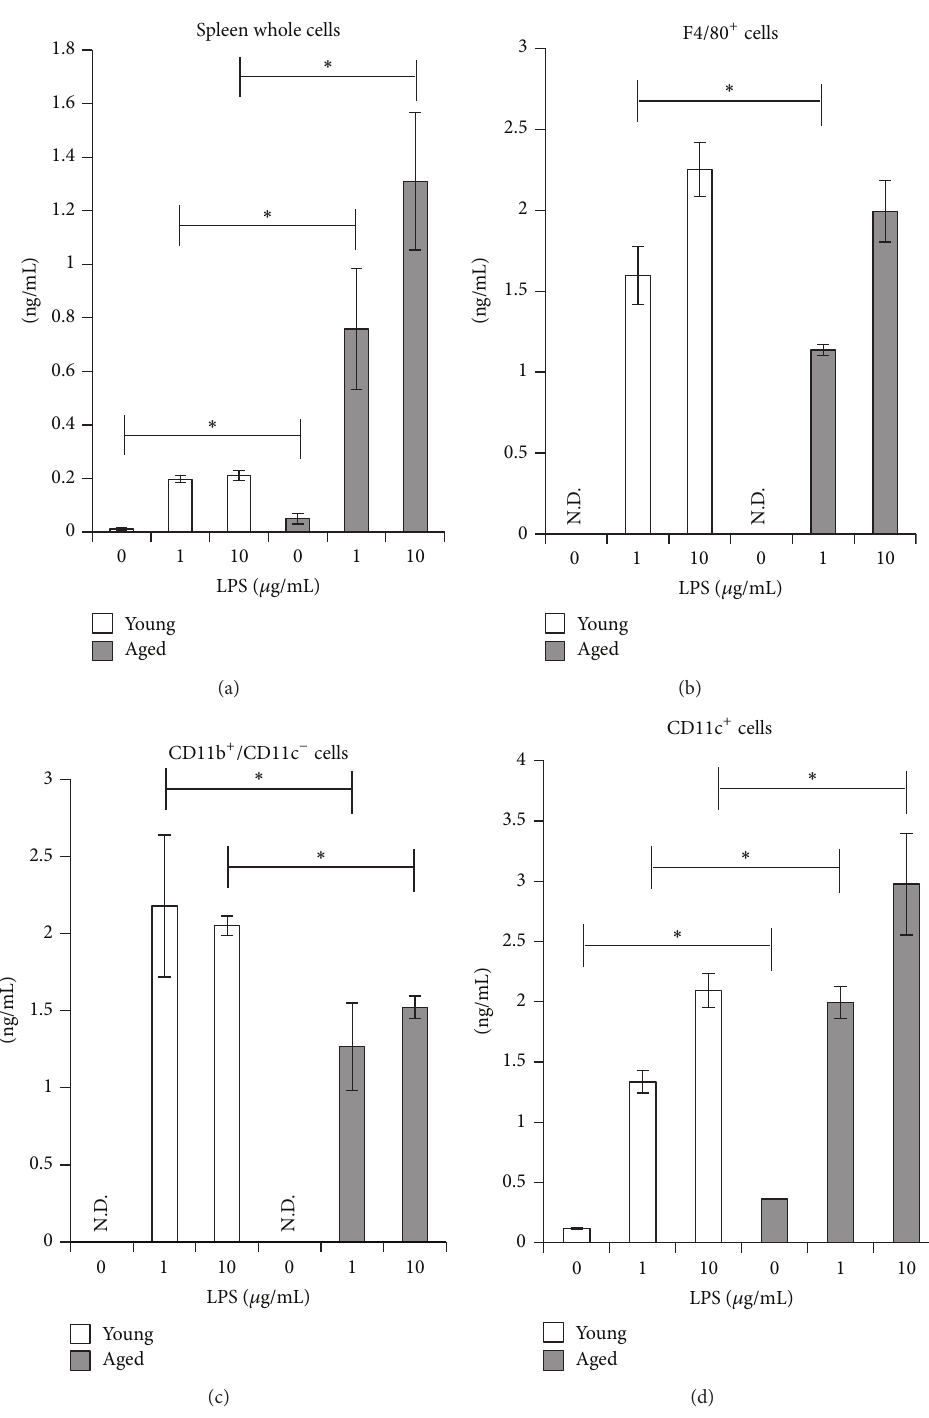
Figure 1: IL-6 protein production in splenocytes and their subpopulations from young and aged mice ( 𝑛 = 2 ∼ 4). Whole splenocytes (a), spleen-derivedF4/80 + cells(b),CD11b + /CD11c − cells(c),andCD11c + cells(d)fromyoungandagedmicewereculturedwith0,1,and10 𝜇 g/mL LPS for 24 hours. Supernatants were collected from the cell culture and IL-6 was measured by ELISA. The results are expressed as mean ± SD. The data are the representative of two similar experiments. ∗ P <